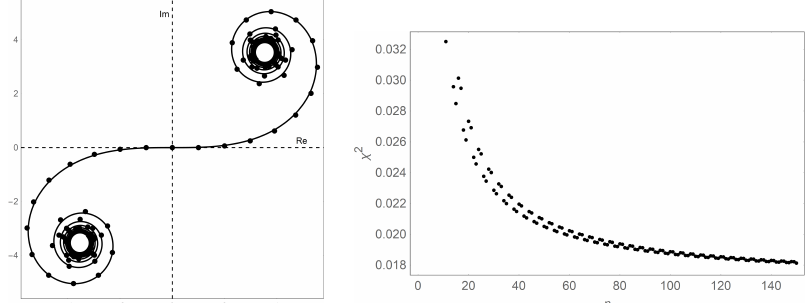
Figure 1. Left panel: Set of partial summation values for F 50,1 . The values of the partial summation for F 50,1 closely follow a Cornu spiral. The values appear equally spaced along the curve. In this case, √ the spacing is 1 . Furthermore, the length of the curve is 2 n + 1 2 50 n = 150. The Cornu spiral models the sequence of partial summations better with increasing n